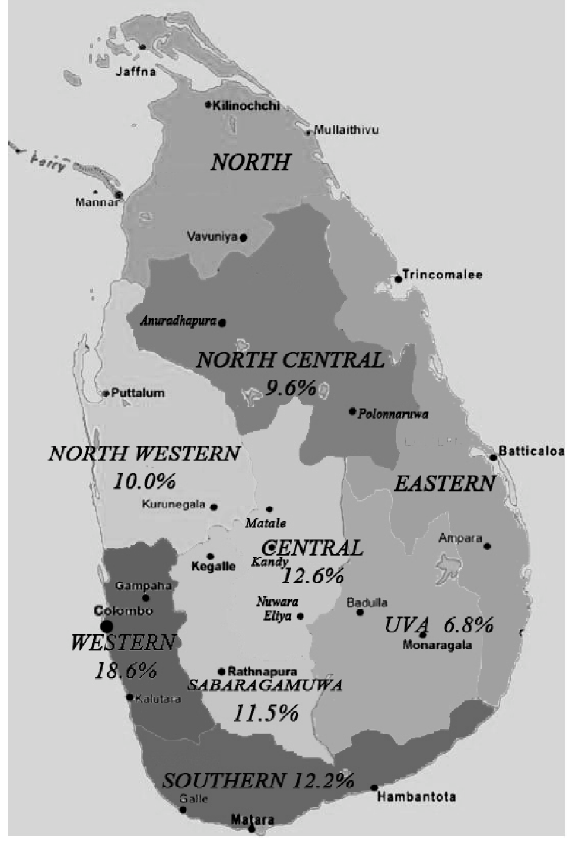
Figure 1. Diabetes map of Sri